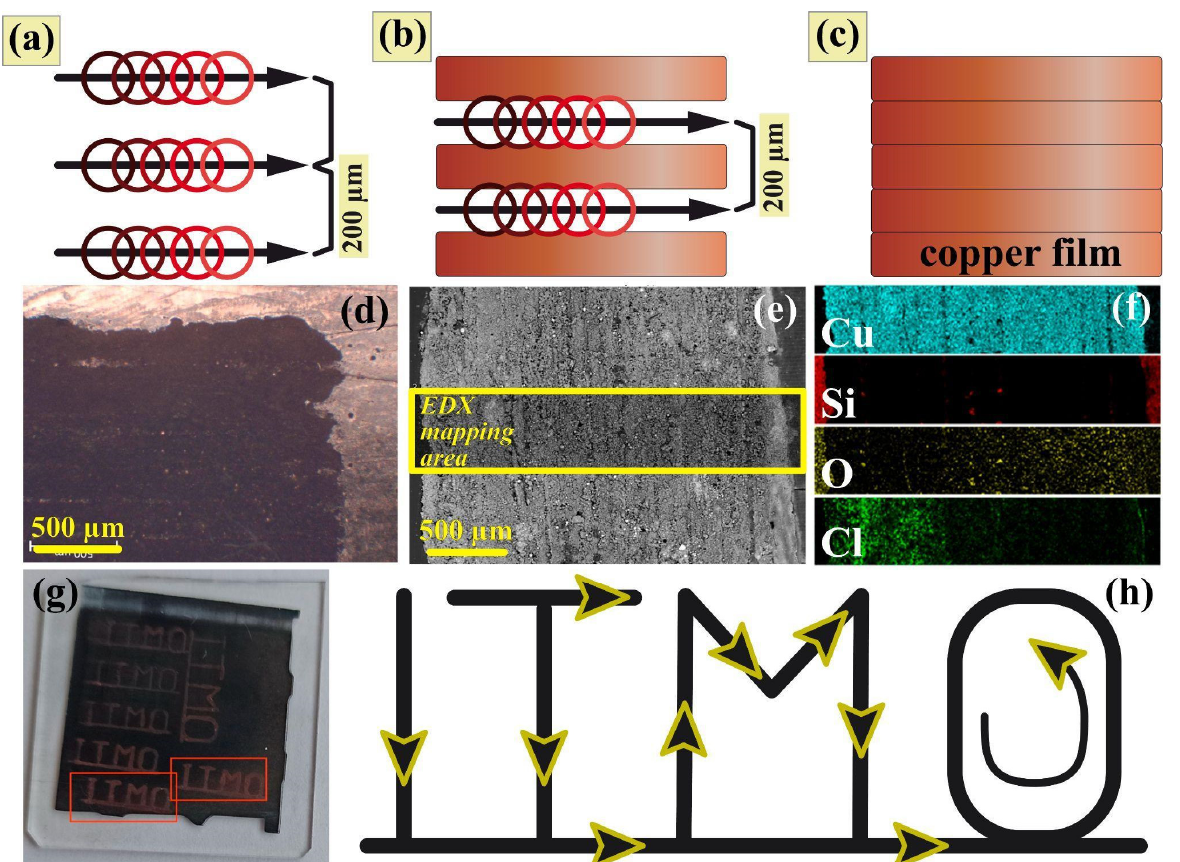
Figure 5. ( a – c ) The continuous -coating recording scheme, ( d ) optical and ( e ) scanning electron microphotography, and ( f ) EDX analysis of the recorded coating structure. ( g ) Photo and ( h ) recording scheme for the structures of arbitrary topology.